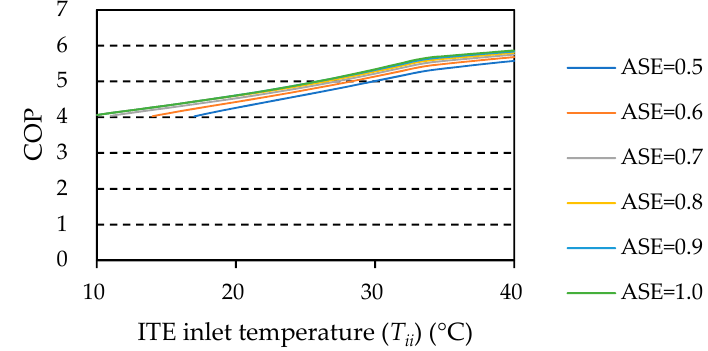
Figure 21. Coefficient of performance (COP) versus ITE inlet temperature ( T ii ).